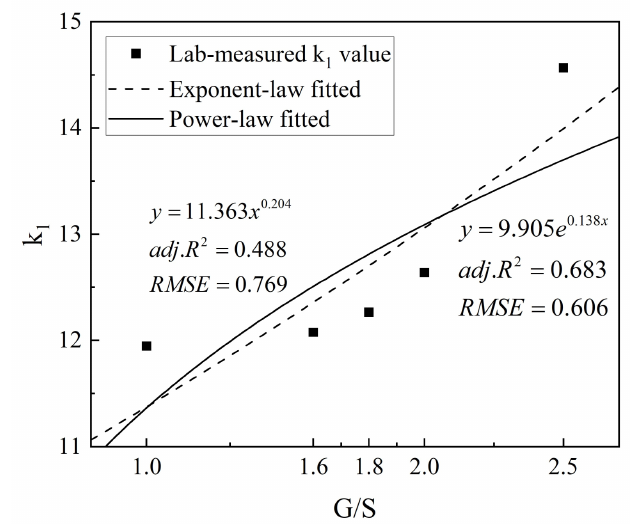
Figure 15. Fitting results of model parameter k 1 against the G/S parameter.